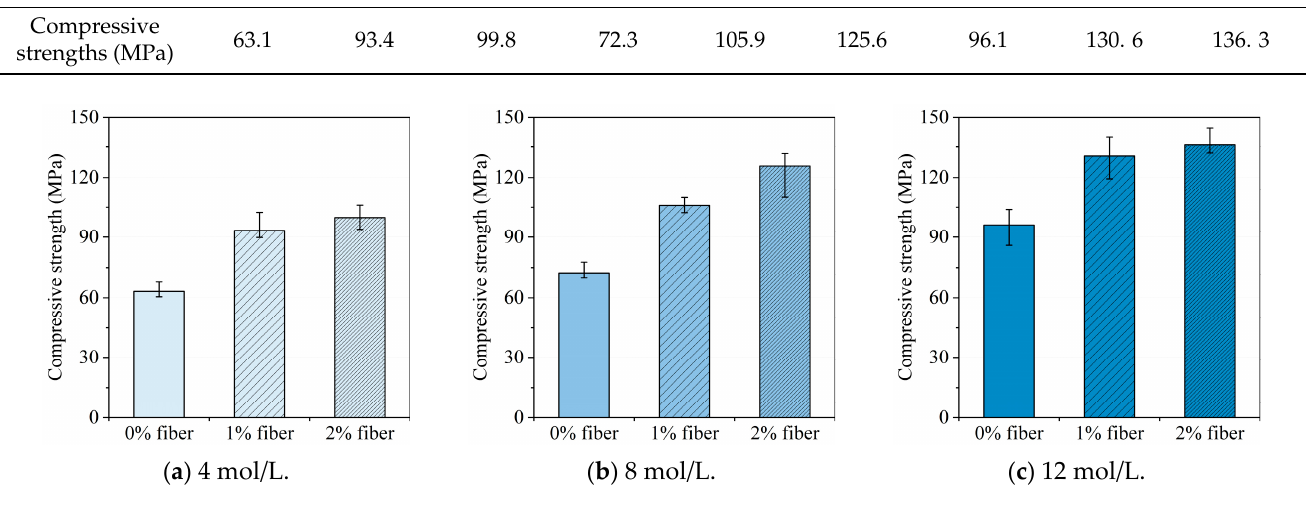
Figure 5. The influence of steel fiber dosage on compressive strength. Table 3. Average compressive strengths for each group of UHPGC.